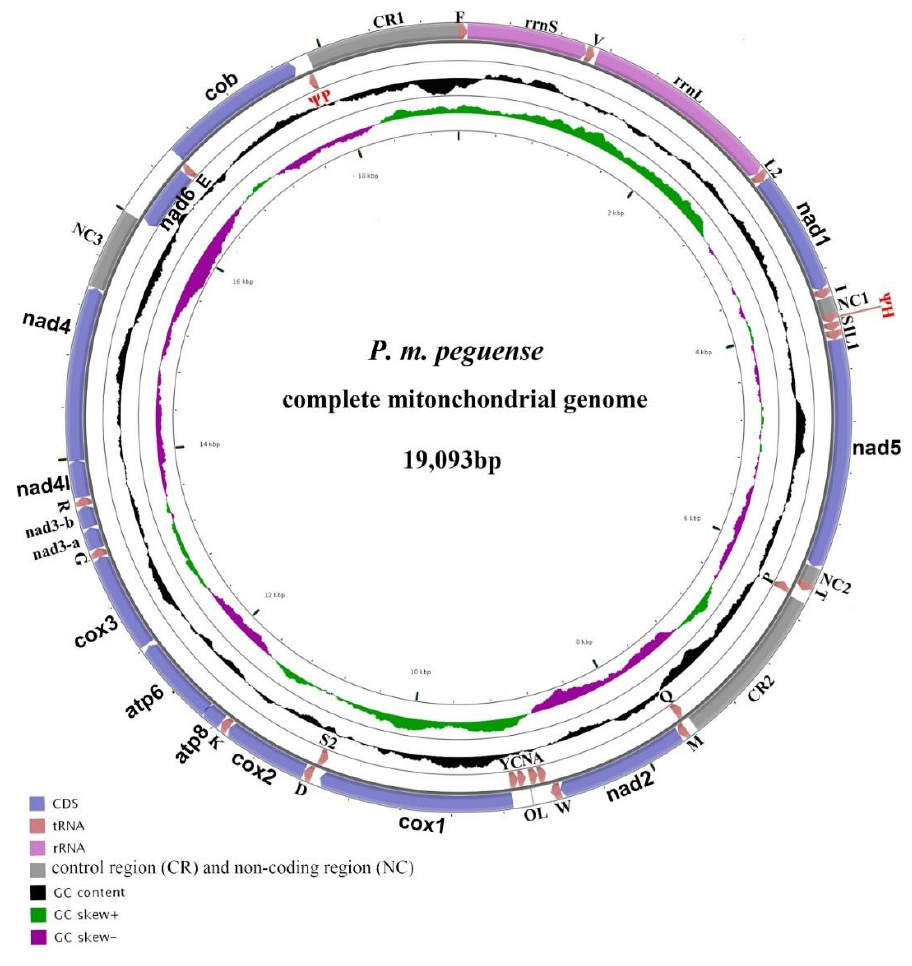
Figure 1. Gene localization in P. m. peguense . The direction of gene transcription is indicated by arrows. Blue arrows represent protein-coding genes (PCGs), pink arrows represent rRNA genes, crimson arrows represent tRNA genes and are designated by single-letter amino acid codes, and red font represents degenerate genes. Non-coding region (NC) and control region (CR) are indicated as gray rectangles. OL represents the replication origin of the L strand. The GC content is plotted using a black sliding window and the GC-skew is plotted using green and violet color sliding windows as the deviation from the average in the complete mitogenome. The figure was drawn using CGView [15] with default parameters.